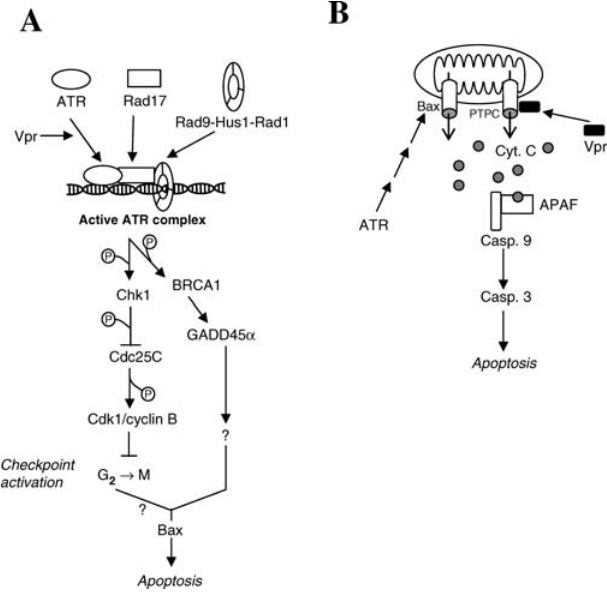
Figure 7. Models to Explain the Activities of HIV-1 Vpr (A). Activation of ATR by Vpr and downstream signaling consequences leading to both G 2 arrest and apoptosis. The functional link between GADD45 a and activation of Bax and the mechanism by which G 2 arrest leads to Bax activation remain unknown (question marks). (B) Binding of Vpr to mitochondrial PTPC was proposed to trigger release of cytochrome c and induction of apoptosis, independently of cell cycle status; in this work, we propose that an alternative pore-forming mitochondrial protein, Bax, is the effector of Vpr-induced apoptosis, and that Bax activation requires upstream stress signals derived from ATR.